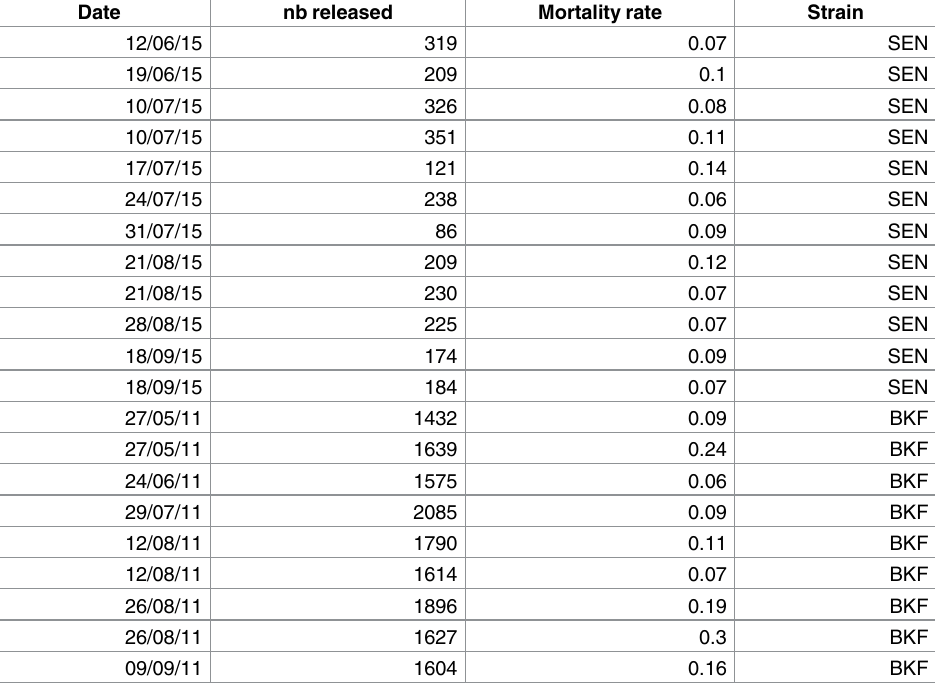
Table 2. Daily mortality of two strains of Glossina palpalis gambiensis in the Parc de Hann, Senegal. Two batches of flies with different colours were releasedwhen the number of pupaewas large enough, in order to make two measures of the mortality rate.